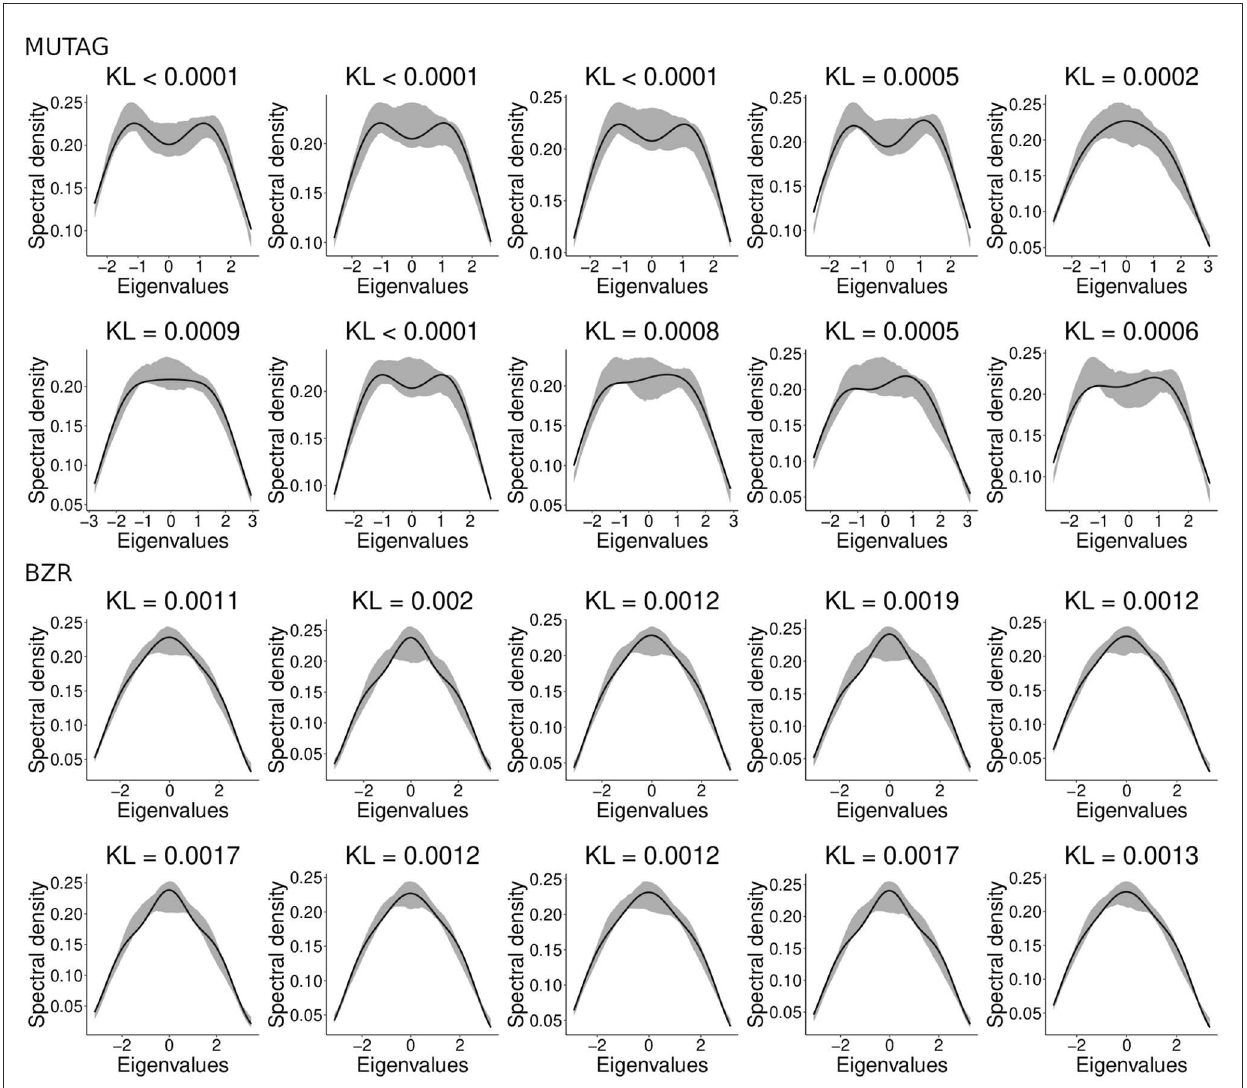
FIGURE7 The adjusted Watts-Strogatz spectral densities for 20 randomly selected chemical compounds. The black line represents the compound’s spectral density. The shaded area represents the 95% confidence interval for the average spectral densities generated by the Watts-Strogatz model and estimated parameters. The indicated KL represents the divergence between the adjusted Watts-Strogatz model and the chemical compound. Notice that most of the chemical compounds’ spectral densities (black line) belong to the gray area, indicating that the Watts-Strogatz model has a good fit for these